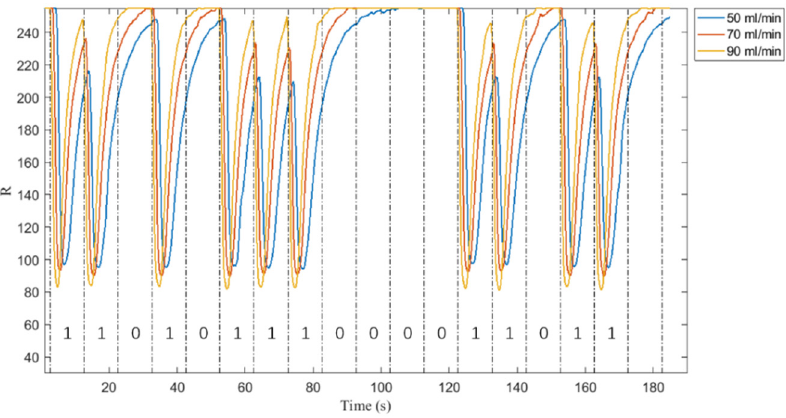
Figure 7. R values at different flow rates.